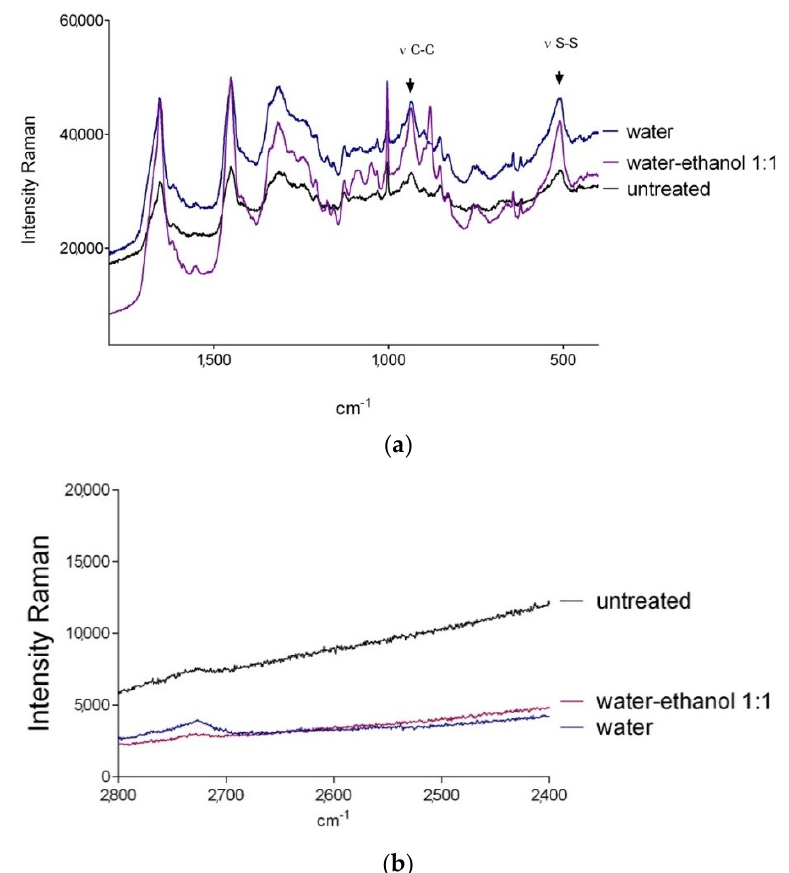
Figure 4. RAMAN spectra of the external surface of the three nail samples studied in an interval of 400–1800 cm −1 ( a ) and 2400–2800 cm −1 ( b ). 400–1800 cm − 1 ( a ) and 2400–2800 cm − 1 ( b